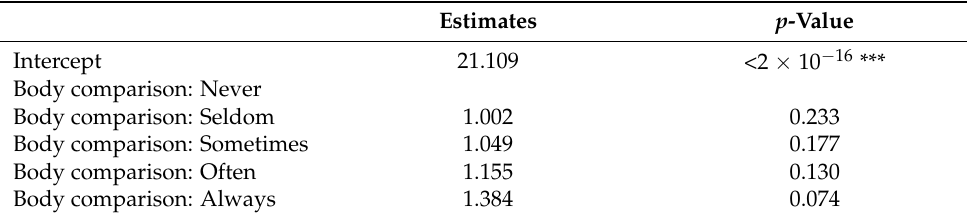
Table 7. One-way ANOVA results looking for a link between BMI and frequency of comparing one’s own physical appearance to that of people followed on social media.